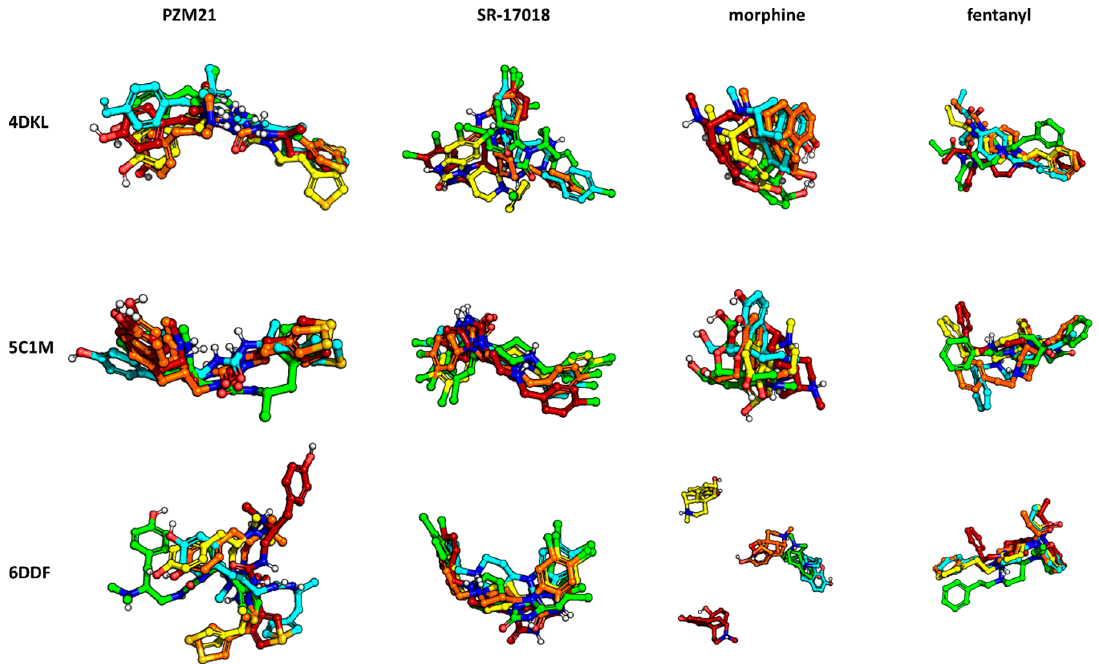
Figure 5. Stability of compound orientations in the binding site during simulations. Green: starting pose; cyan: 250th frame; orange: 500th frame; yellow: 750th frame; red: 1000th frame.